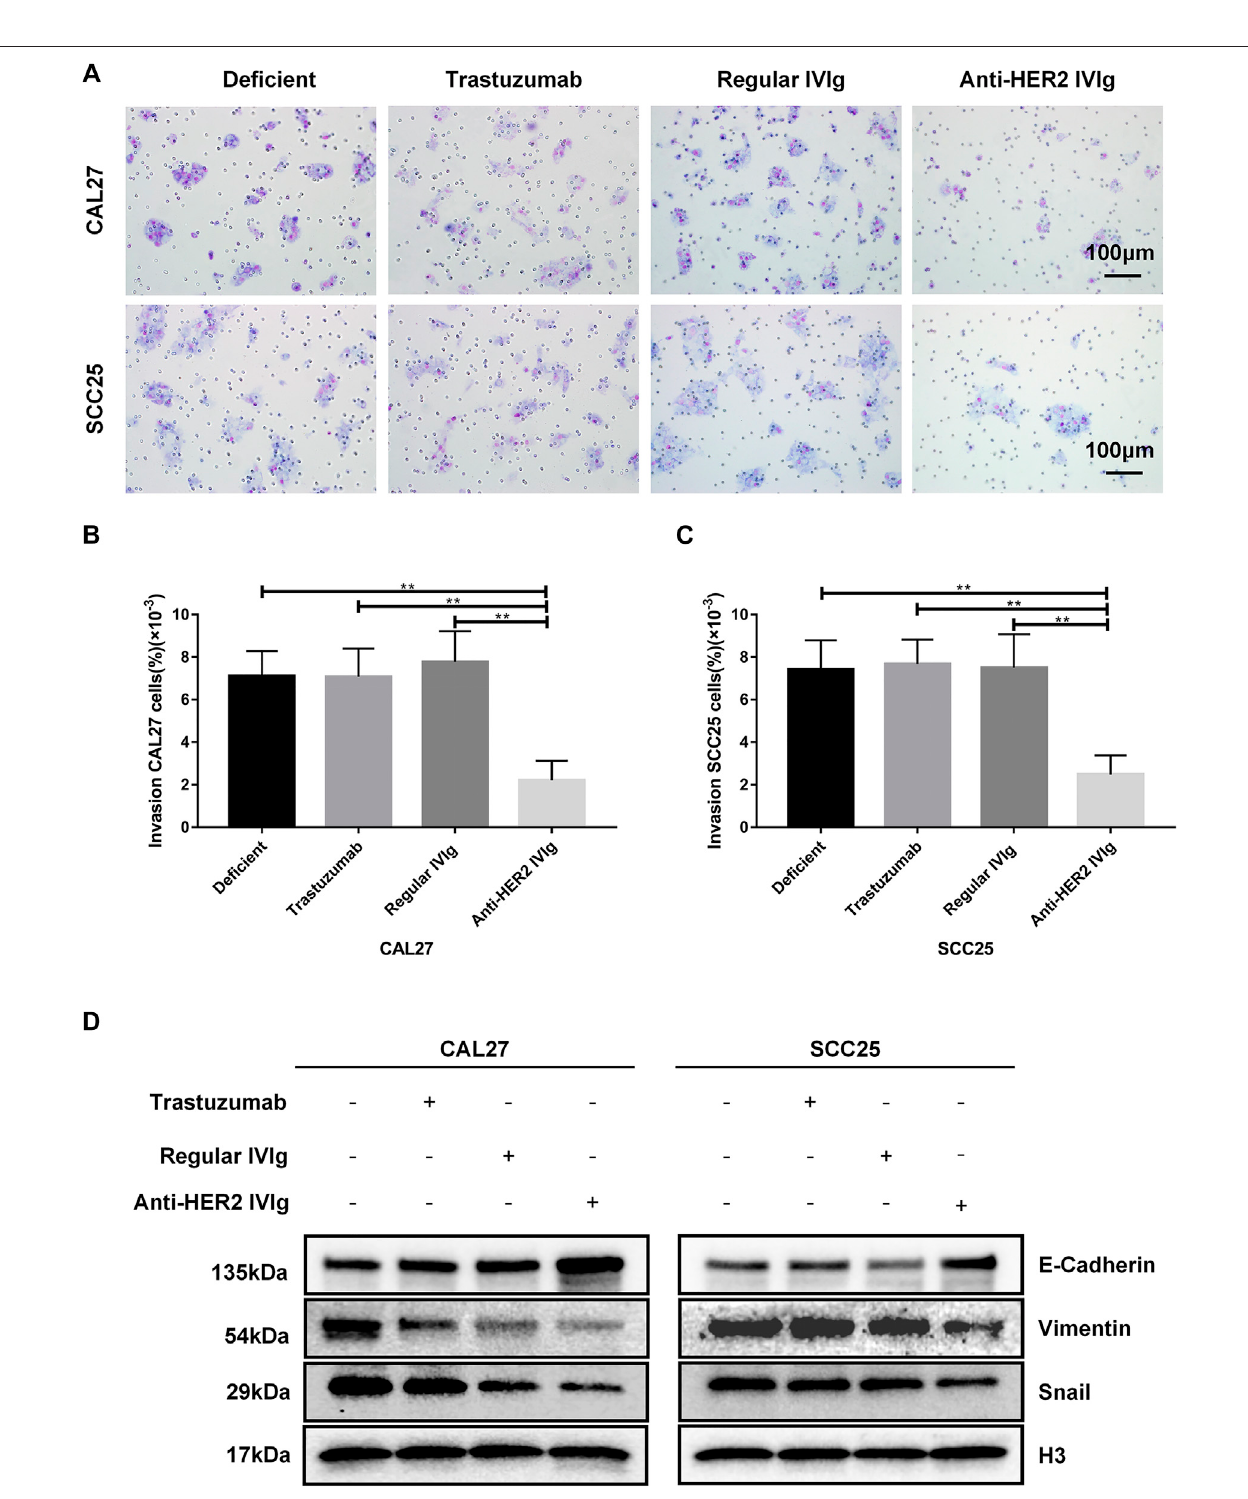
FIGURE6| Inhibitoryeffects ofanti-HER2IVIgonOSCC cellsmigration. (A – C) CAL27and SCC25cellstreatedfor48 hwithanti-HER2IgG-de fi cientplasmaonly, 200 μ g/mltrastuzumab,5 mg/mlregularIVIg,and5 mg/mlanti-HER2IVIg,respectively,werephotographed;barchartshowedtheproportionofinvasivecellsrelativeto thetotalnumberofseedingcells. (D) CAL27andSCC25cellswereculturedfor48 hwithanti-HER2IgG-de fi cientplasmaonly,200 μ g/mltrastuzumab,5 mg/mlregular IVIg, and 5 mg/ml anti-HER2 IVIg, respectively;theexpression ofEMT-related factors, E-cadherin,Vimentin,orSnailwasthendeterminedbyWestern blotwithH3 as a reference. De fi cient: anti-HER2 IgG-de fi cient plasma; IVIg: intravenous immunoglobulin; * p < 0.05; ** p < 0.01.